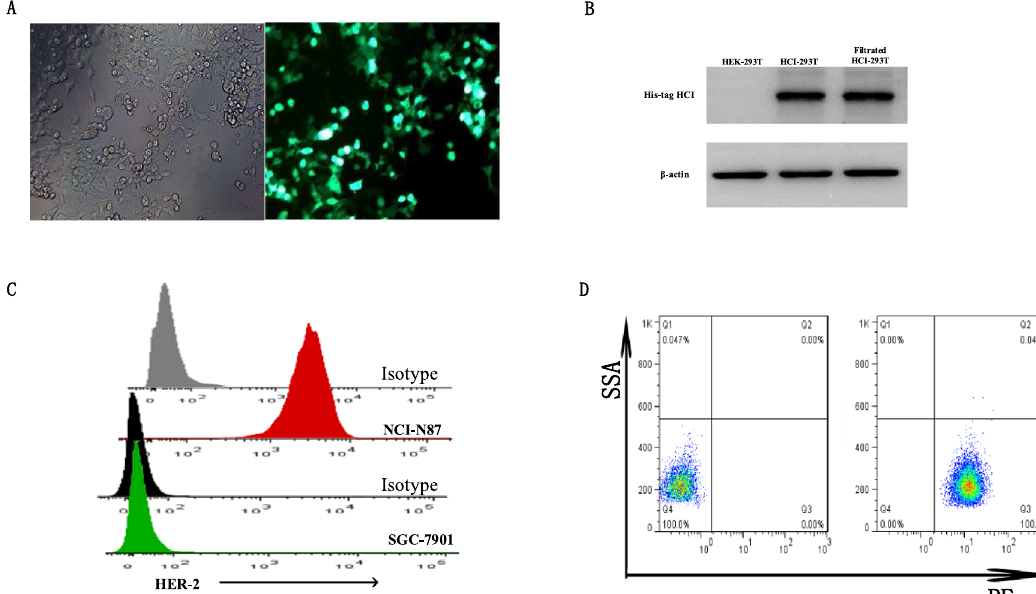
Figure 2. HCI production and HER-2 expression on the gastric tumor cell surface. ( A ) HEK-293 T cells were transfected with HCI fusion protein packing lentivirus containing a GFP cassette. Seventy-two hours after transfection, transfection efficiency was observed under either an optical microscope (left) or fluorescence microscope(right). ( B ) HCI fusion protein expression was determined by Western blot analysis and the blots were cut prior to hybridization with antibodies. ( C ) The expression of HER2 on the tumor cell surface in SGC7901 and NCI-N87 cells was detected by FCM. (D ) Flow cytometry showed that the HIC fusion protein bound to the HER-2 antigen expressed on the NCI-N87 cell surface (right). NCI-N87 cells treated with the nonHCI fusion protein were used as control